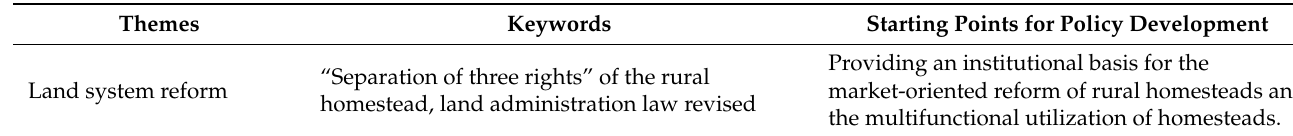
Table 5. Themes, major keywords, and starting points for policy formulation in the evolution of the function of rural